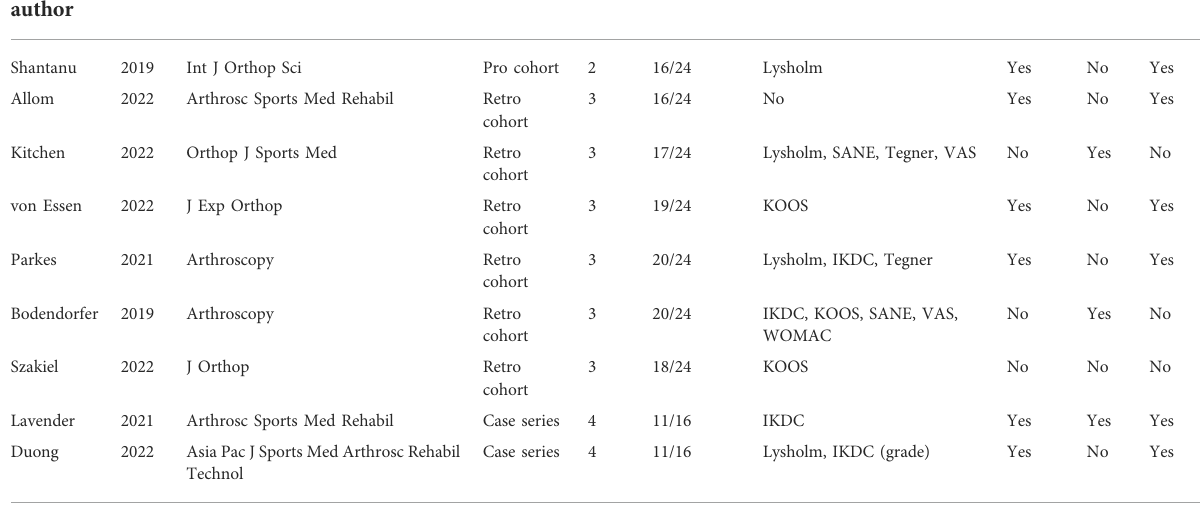
TABLE 2 Study feature and methodologic quality.